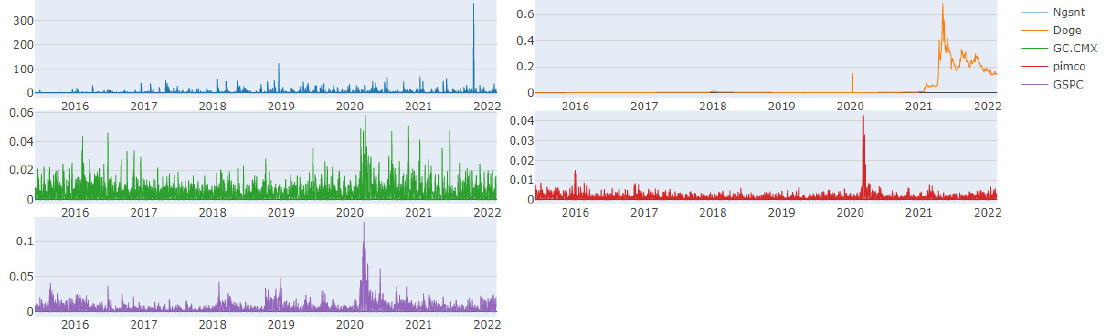
Figure 1. Raw data representing all the five variables.